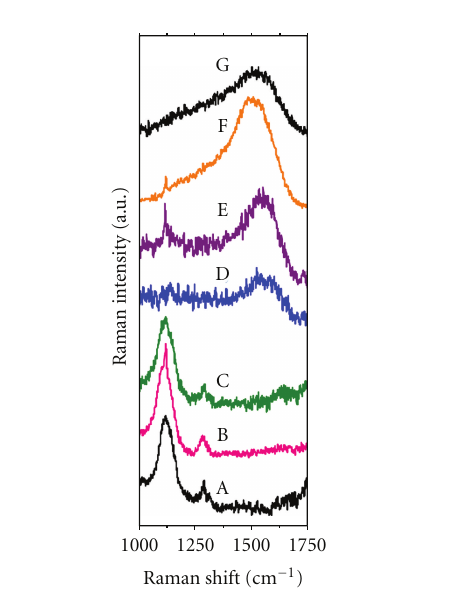
Figure 4: An expanded view of the normalized Raman spectra of the 1550 cm − 1 mode. A comparison between measured (dotted curve) and calculated first-order Raman line shapes of ion- implanted B 6 O. Again, the y -axis is normalized, and the spectra are shifted along the y -axis for better comparison.